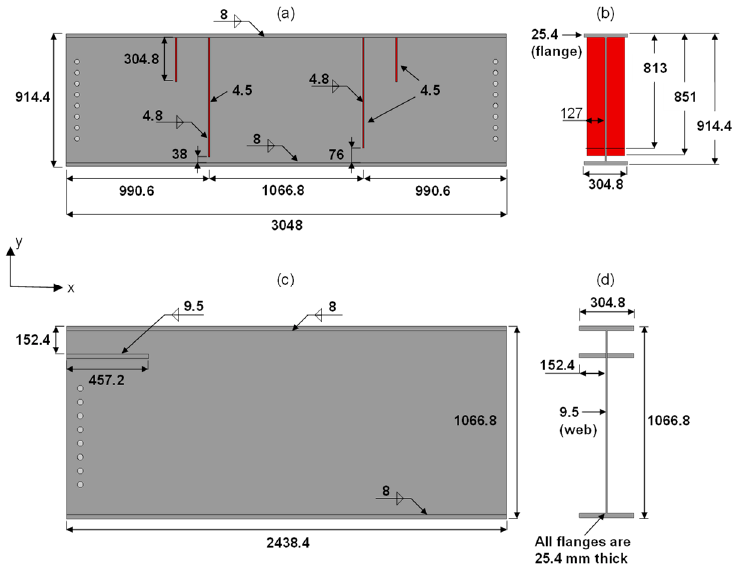
Figure 6. Fatigue test of distortion-induced fatigue sensitive detail: ( a , c ) girders and ( b , d ) sections dimensions (units: millimetres).